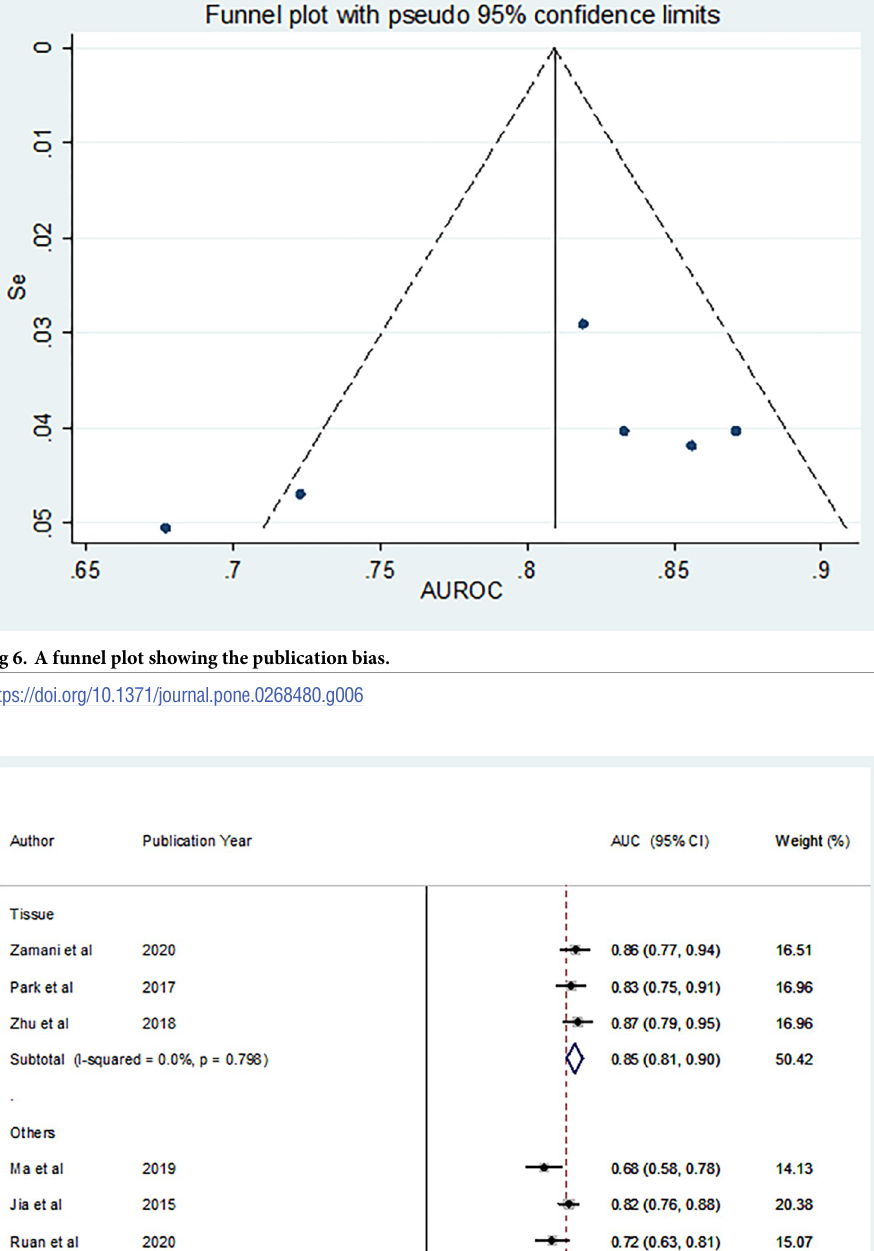
PLOS ONE | https://doi.org/10.1371/journal.pone.0268480 July 27,